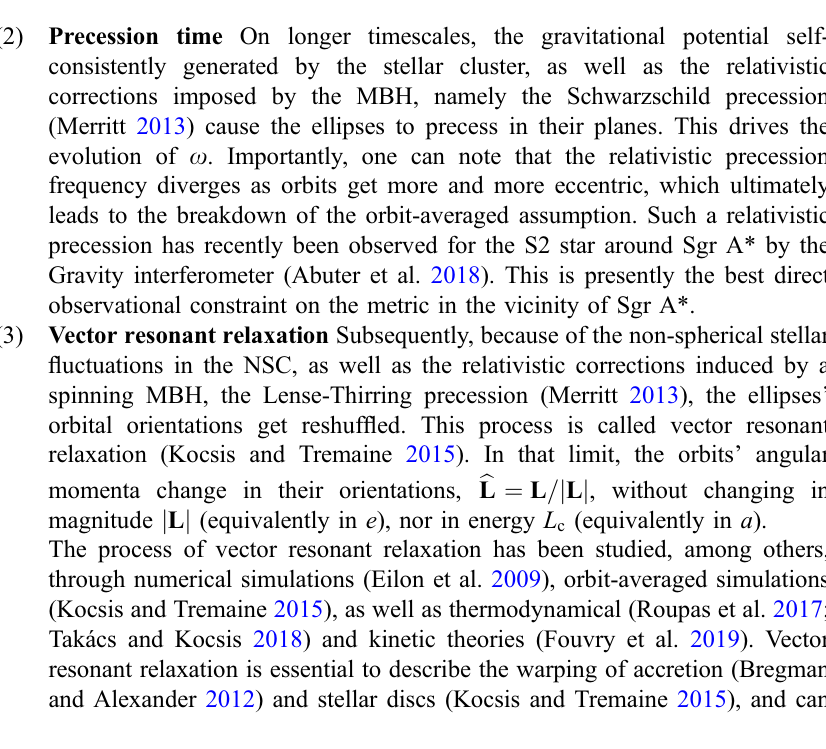
Fig. 30 Illustration of the hierarchy of timescales in a NSC: (1) the dynamical time; (2) the precession time; (3) the vector resonant relaxation time; (4) the scalar resonant relaxation time; (5) the two-body relaxation